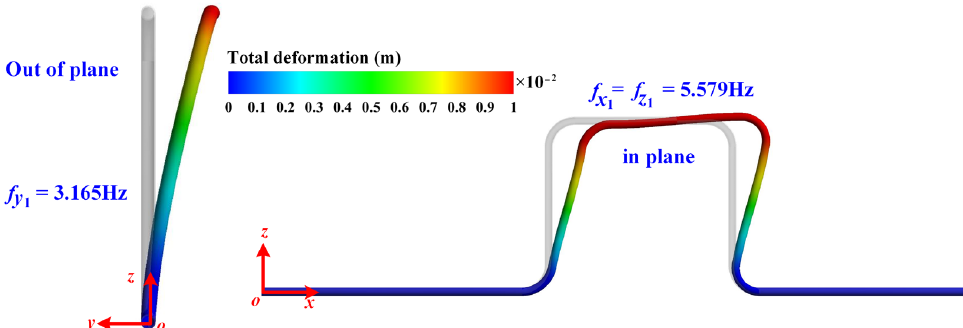
Figure 2. The monitored mass flow rates ( Q m ) in both the inlet and outlet, here taking Q G and Q L = 144 kg/s for instance, where Q m-in and Q m-out represent the mass flow rate in the inlet and outlet boundaries, respectively, and superscript L and G denote the liquid and gas, respectively.